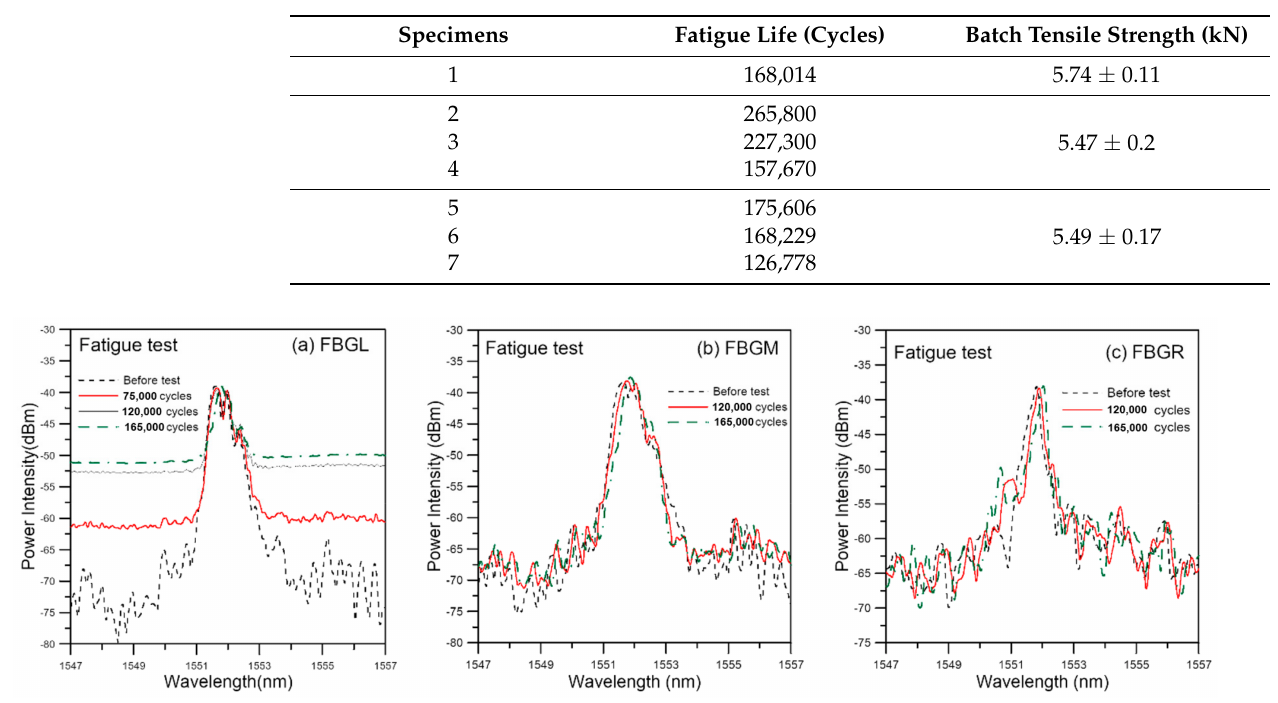
Figure 9. Evolution of unload FBG spectra during fatigue cycling of a virgin